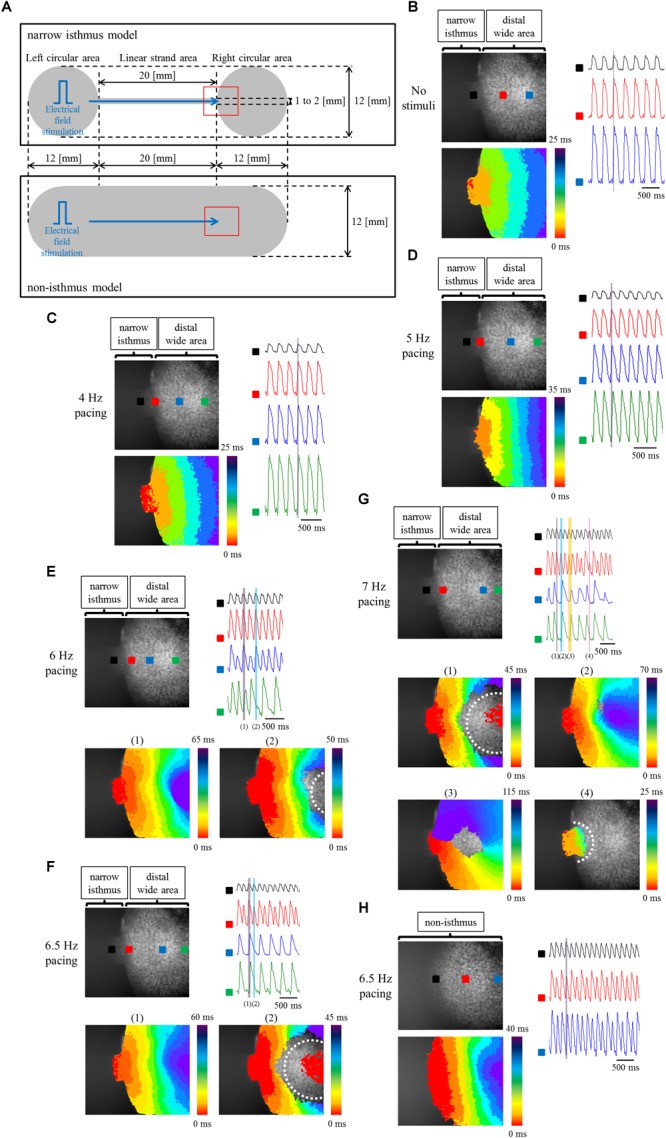
(A) Frame design of the fabricated plates in the narrow isthmus model (upper panel) and non-isthmus model (lower panel). The recording site of optical mapping is illustrated by the hollow red square. Blue arrow indicates the direction of electrical conduction generated by electrical field stimuli. (B–G) Optical mapping of a narrow isthmus model containing atrial-like hiPSC-CMs alone under spontaneous beating with no electrical stimuli (B), constant pacing at 4 Hz (C), 5 Hz (D), 6 Hz (E), 6.5 Hz (F), and 7 Hz (G). 1 to 1 conduction (C,D), conduction delay [E-(1)] and intermittent regional block (crab claw-like conduction) [E-(2)], 2:1 conduction block [F-(1): conduction delay, F-(2): regional block (crab claw-like conduction)], various types of conduction disturbance (G-(1): regional block (crab claw-like conduction), G-(2): conduction delay, G-(3): unidirectional block, G-(4): omnidirectional block) were observed. (B-G upper left panel) The recorded field in the preparation. OAP waveforms were acquired at each ROI as indicated by a solid square. (B–D lower left panel, E,F lower panel, G middle and lower panel) Activation map on the recorded field during the time range denoted by the light purple, light blue, light orange, or light pink rectangle in the right (upper) panel. White dotted line indicates the estimated conduction block line. Color bar denotes total activation time (ms). (B–D right panel, E–G right upper panel) Representative OAP waveforms acquired at each ROI as indicated by a solid square in the upper left panel. Light purple, light blue, light orange, or light pink rectangle designates the time range during which the activation map was developed. Time scale bar, 500 ms. (H) Optical mapping of a non-isthmus model containing atrial-like hiPSC-CMs alone under constant pacing at 6.5 Hz. 1 to 1 conduction was maintained at 6.5 Hz. (Upper left panel) The recorded field in the preparation. OAP waveforms were acquired at each ROI as indicated by a solid square. (Lower left panel) Activation map on the recorded field during the time range denoted by the light purple rectangle in the right panel. Color bar denotes total activation time (ms). (Right panel) Representative OAP waveforms acquired at each ROI as indicated by a solid square in the upper left panel. Light purple rectangle designates the time range during which the activation map was developed. Time scale bar, 500 ms. Please be careful not to misunderstand the indication of the activation mapping in F-(2) and G-(1): the red-colored activation pattern at the center of the blocked zone does not mean competition with an emerging focus within the blocked zone, but is caused by the detection of the previous OAP intensity at the late phase of repolarization at the ROI. Please note that the light blue rectangle in the right upper panel of F and the light purple rectangle in the right upper panel of G are correspond to the timing of the late repolarization phase of the each previous OAP at the ROI.